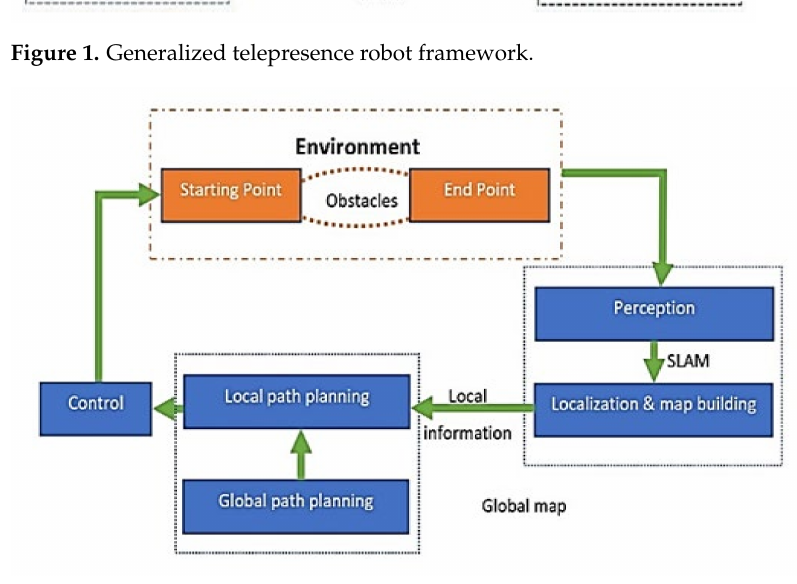
Figure 2. Generalized algorithm flow of a remote-controlled telepresence